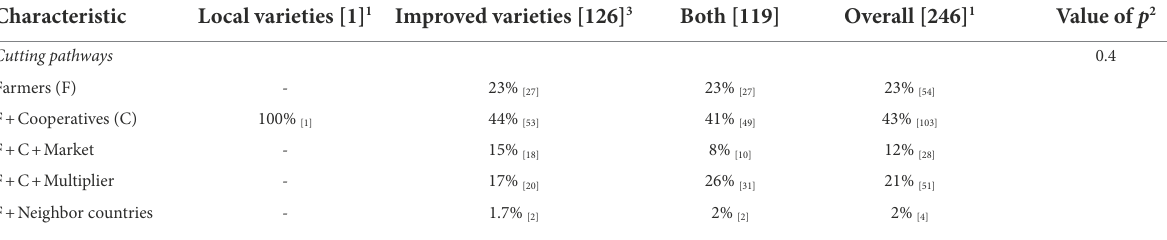
TABLE 7 Proportion of fields grown by types of cassava varieties from different pathways.